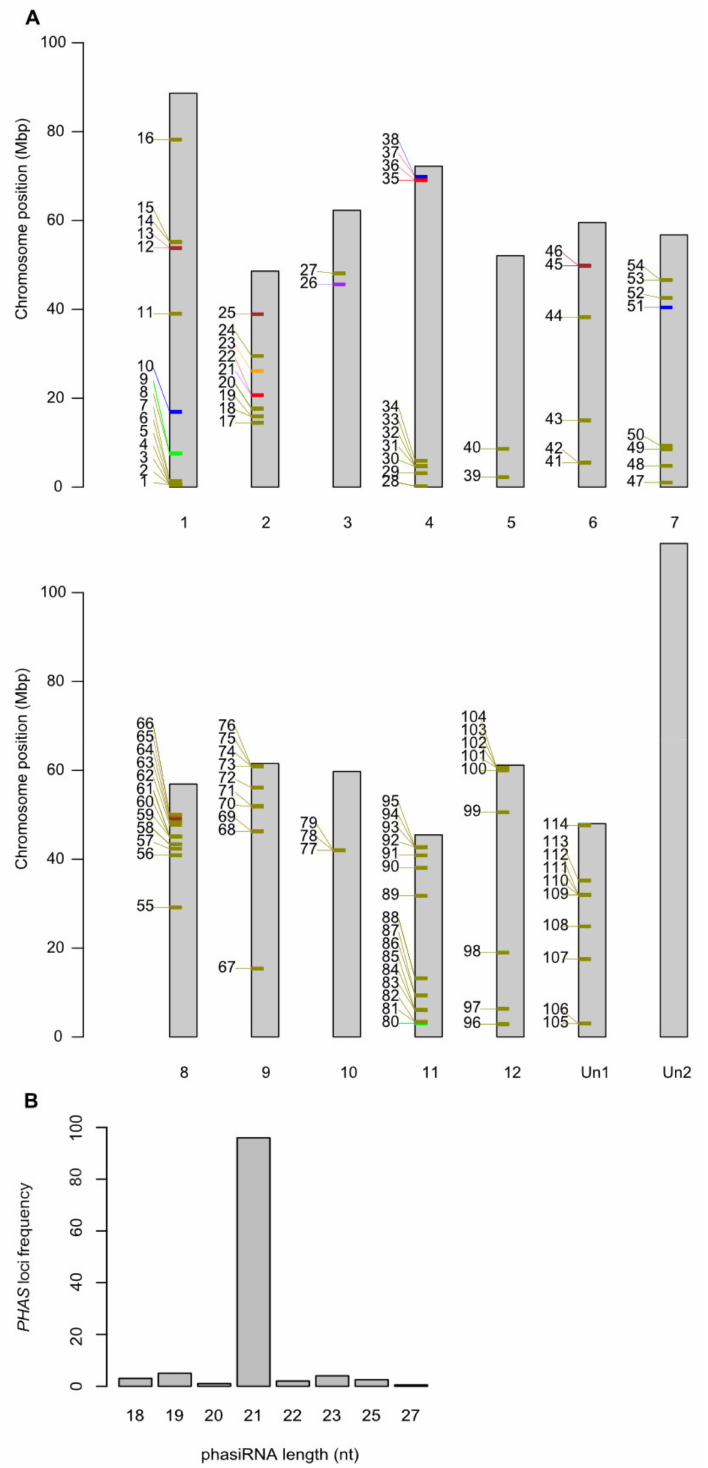
Figure 3. PHAS loci and size frequency. ( A ) One hundred and fourteen PHAS loci were predicted by Phasetank from all sRNA reads included in the analysis and mapped on the potato chromosomes. Colors illustrate phasiRNA nt length (18 = blue, 19 = red, 20 = orange, 21 = dark gold, 22 = green, 23 = brown, 25 = purple, 27 = black). Un1 and Un2 are the unanchored sequences from the potato genome version 4.03 and 4.04, respectively. ( B ) Frequency of PHAS loci in relation to phasiRNA length (nt). One locus produced both 25 and 27 nt sRNA, and hence each nt length was assigned 0.5 for that loci. Details on the different PHAS loci are given in Table